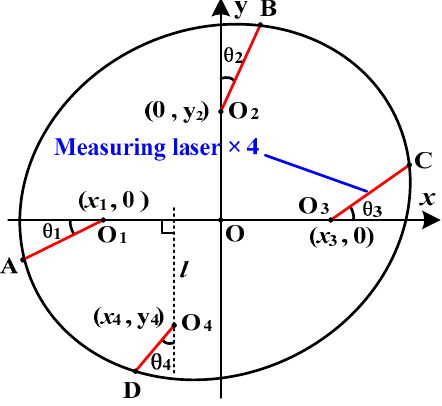
Figure 5. Single-module measurement model.